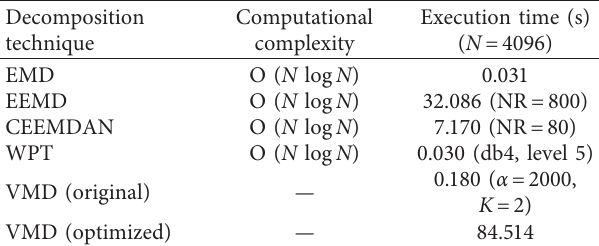
Table 2: The computational cost of the presented decomposition techniques.